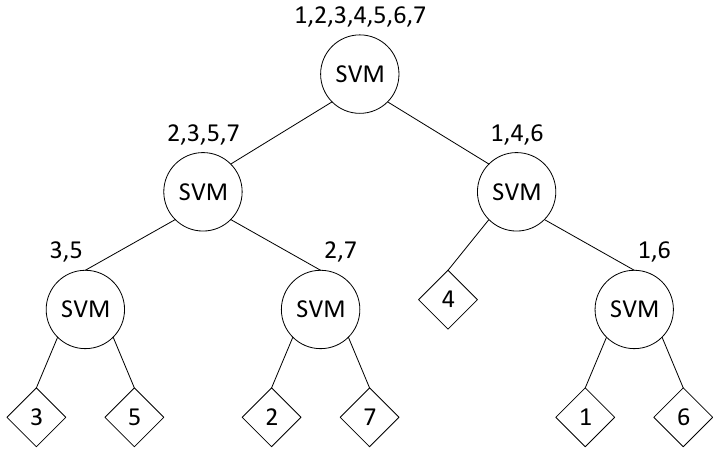
Figure 4. Illustration of SVM-binary tree architecture